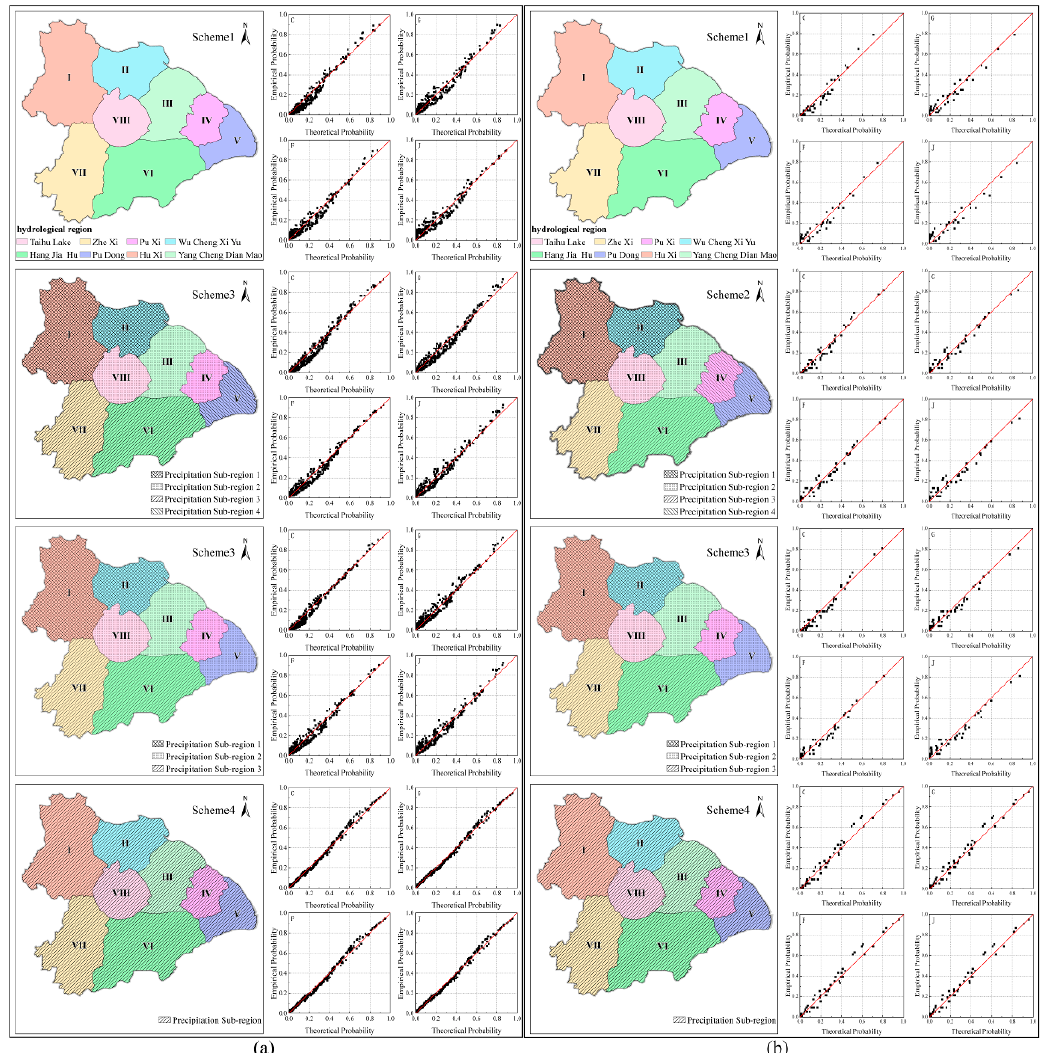
Figure 6. Precipitation sub-region divisions and the probability-probability plots of regional precipitation and the Taihu Lake water level in the typhoon period ( a ) and plum rain period ( b ). C is short for Clayton copula; G is short for Gumbel copula; F is short for Frank copula; J is short for Joe copula. Table 6. Goodness-of-fit tests for the copula functions in the plum rain and typhoon periods.